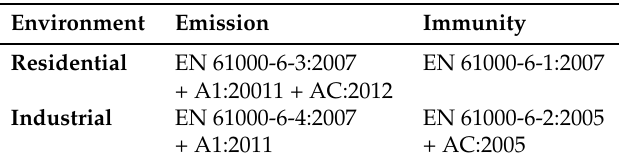
Table 4. Harmonized standards for emission and immunity.